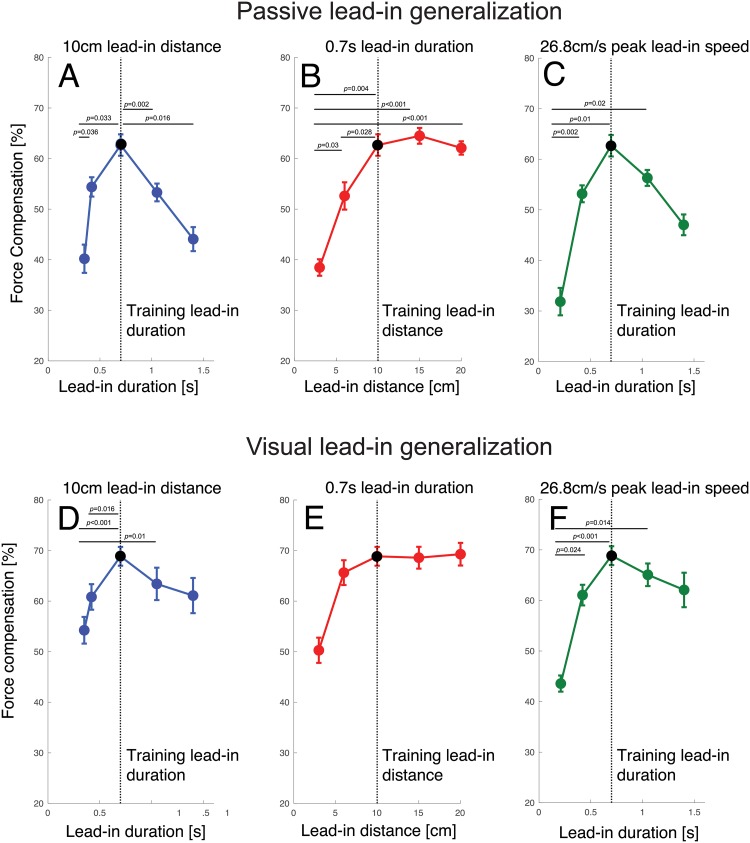
Generalizations results for both passive and visual lead-in conditions plotted for fixed values of lead-in distance, lead-in duration and lead-in speed.A-C Results of passive lead-in experiments. The dotted lines indicate the training values of lead-in distance and lead-in duration. Error bars indicate standard error of the mean. Significant differences are indicated for post-hoc comparisons (Holm corrected for multiple comparisons). A Effect of changing lead-in duration for fixed 10 cm lead-in distance. In this panel, lead-in distance is held constant and the movement duration (shown on the x-axis) and speed vary. B Effect of changing lead-in distance (and peak speed) across conditions with a fixed 700 ms lead-in duration. C Effect of changing lead-in duration (and distance) across conditions with a fixed 26.8 cm/s lead-in speed. D-F Corresponding results for visual lead-in condition.